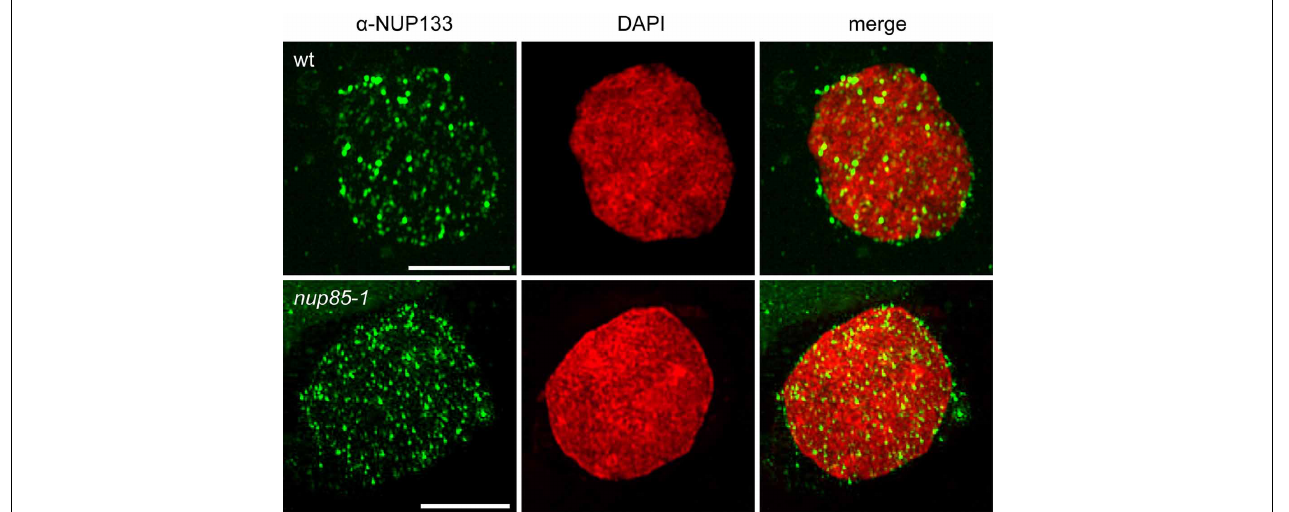
FIGURE 1 | Indirect immunolocalization of L. japonicus NUP133. 3D structured illumination microscopy (Z-stack) detected a punctated NUP133 signal around the nucleus, corresponding to individual NPCs or clusters of nuclear pores. No change to NUP133 localization was